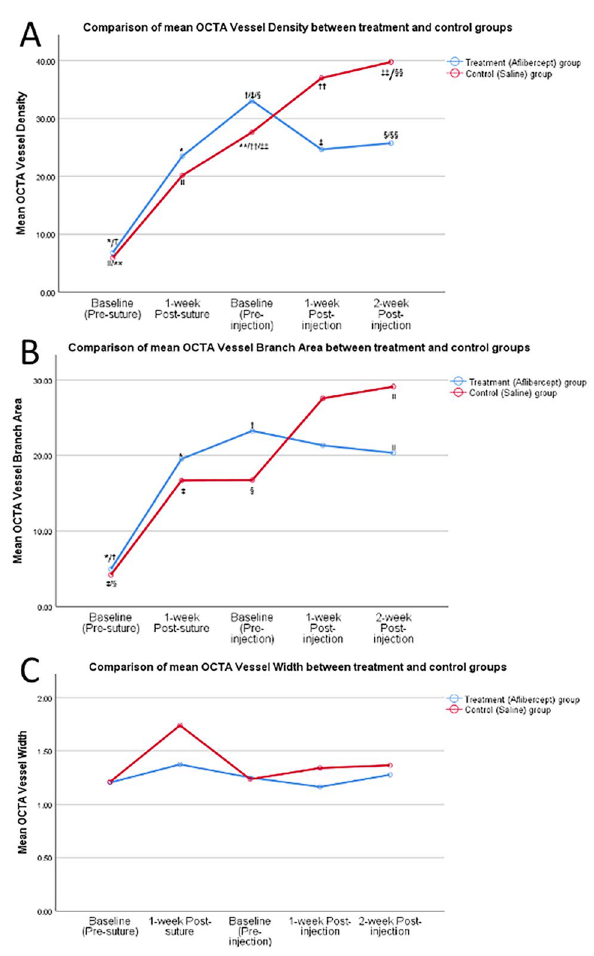
Figure 4. Changes in anterior segment optical coherence tomography angiography (AS-OCTA) determined vascular parameters following corneal suturing to induce corneal vascularisation and subconjunctival aflibercept injections (treatment group) or saline injections (control group). ( A ) Changes in mean vessel densities; ( B ) changes in mean vascular branch area; ( C ) changes in mean vessel width. * , † , ‡ , § , II , ** , †† , ‡‡ , §§ denote statistical significance between two comparative points, p < 0.05).